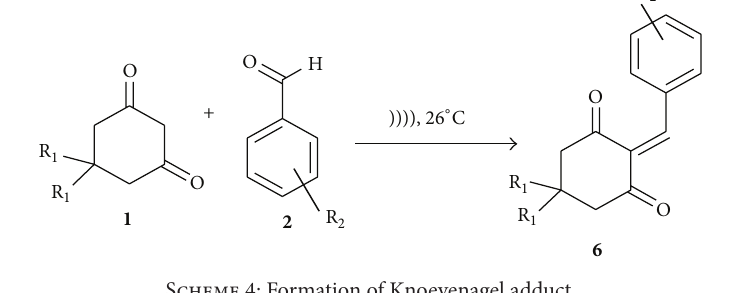
Scheme 4: Formation of Knoevenagel adduct.